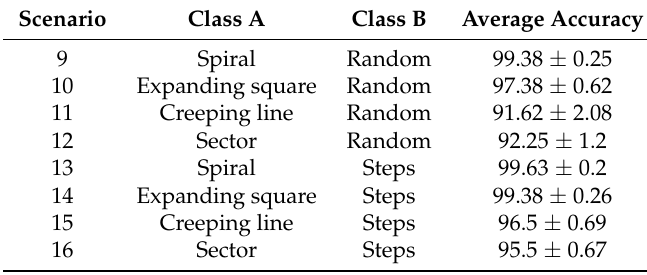
Table 4. Results for the binary classification scenarios for complex patterns. The average accuracy scores are reported in the 95% confidence